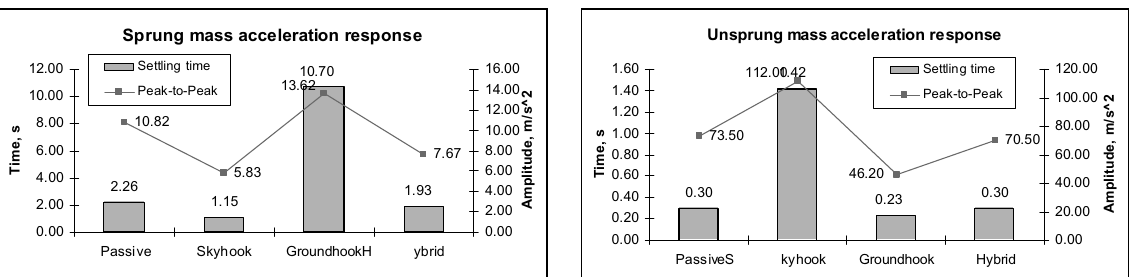
Fig. 5. Tire deflection response.